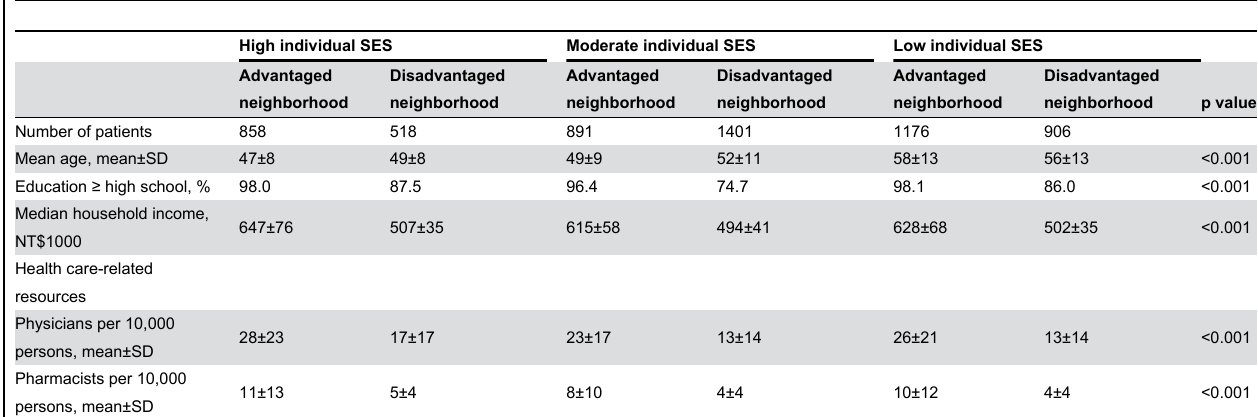
Table 4. Sociodemographic characteristics by individual and neighborhood socioeconomic status ( n